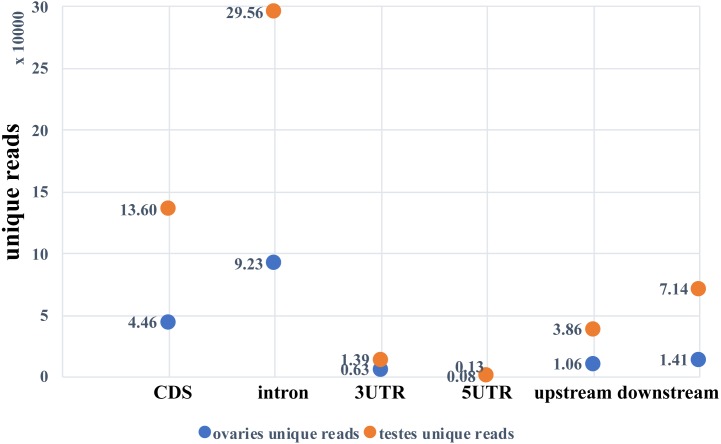
Unique reads mapped to the genome.